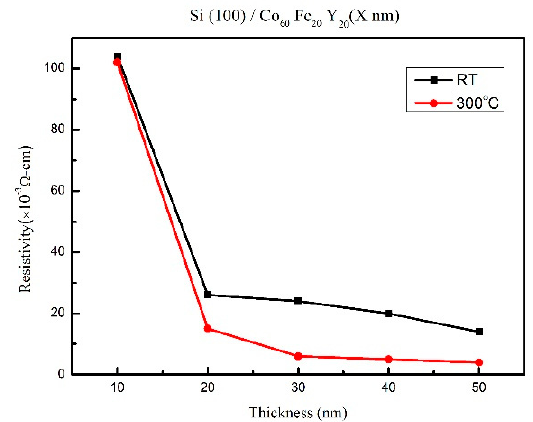
Figure 7. Resistivity of CoFeY films.